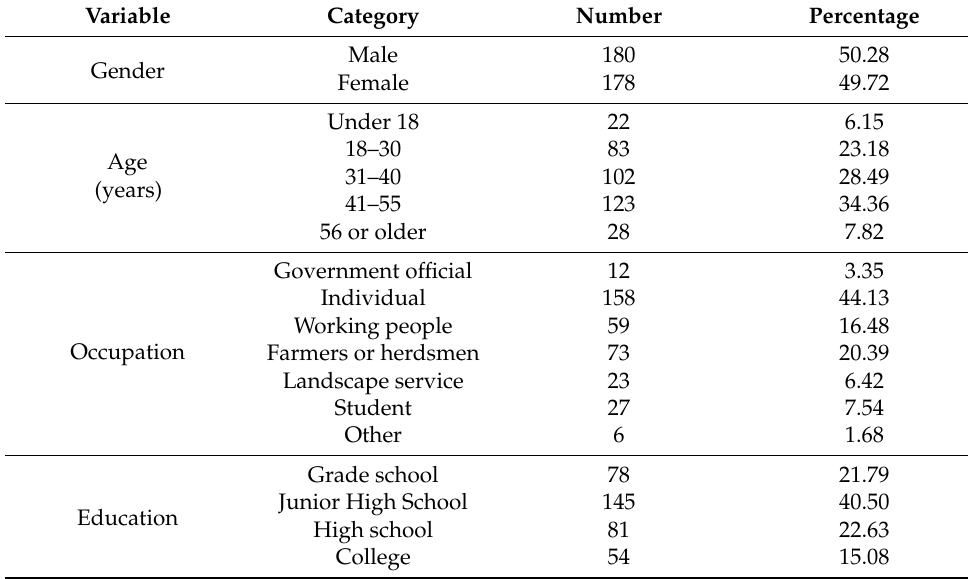
Table 1. Basic characteristics of sample